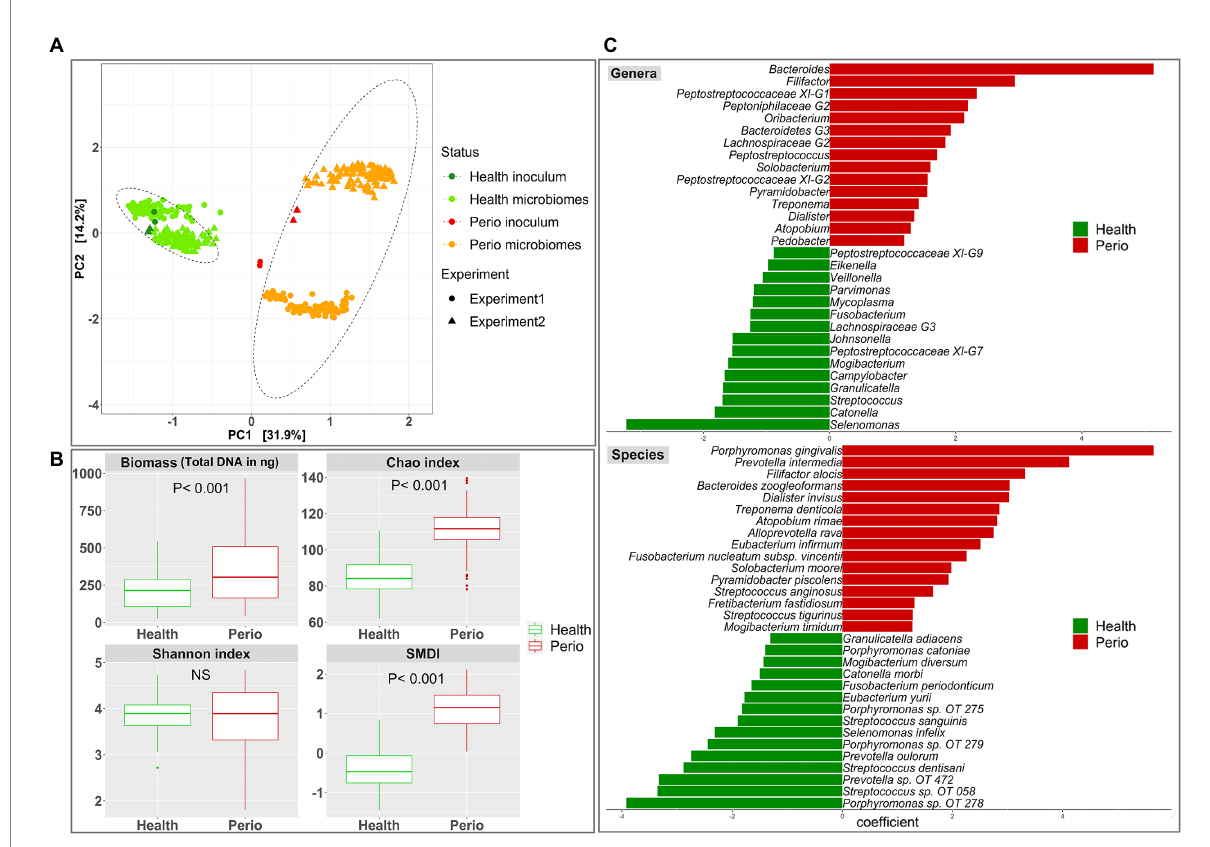
FIGURE 2 In vitro microbiomes from health and periodontitis. (A) Principal component analysis (PCA) plots based on centered log-ratio (CLR) transformed data as a function of health status and experimental replicates. (B) Boxplots of biomass, alpha diversity indices, and subgingival microbial dysbiosis index (SMDI) in the health- and periodontitis-derived microbiomes. Statistical comparisons were performed using Mann–Whitney test. (C) Top differentially abundant genera and species between the health- and periodontitis-derived microbiomes with FDR value < 0.1 and coefficient > 2 or < − 2 (MaAsLin2 analysis on CLR transformed data with health status, biological replicate, medium, shaking and incubation time as fixed effects and technical replicates as random effects). Plots were produced with